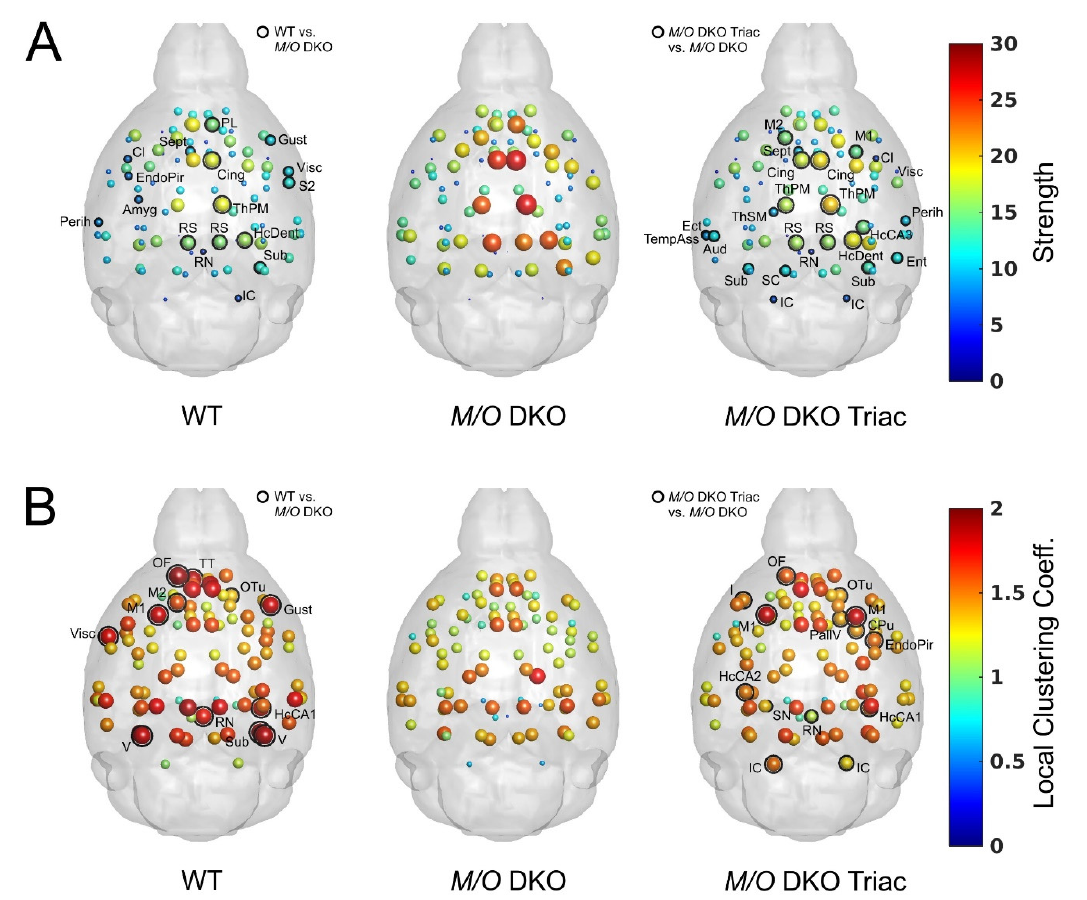
Figure 5. The differences in local graph metrics between WT, Mct8/Oatp1c1 DKO and Mct8/Oatp1c1